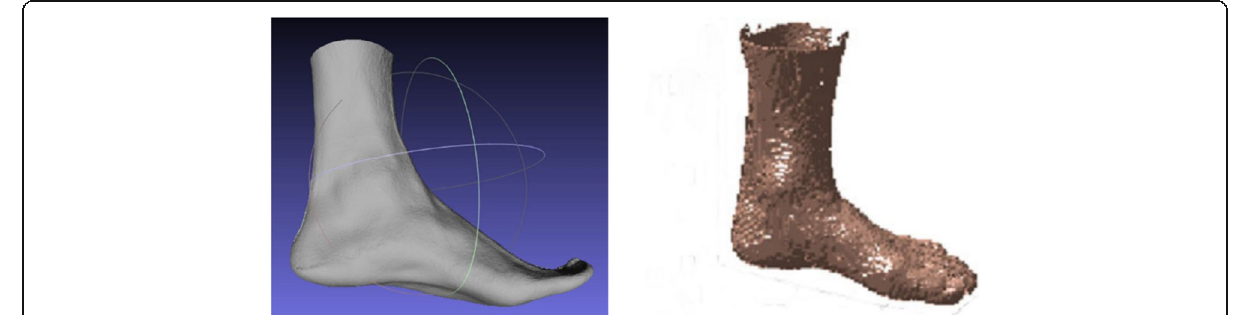
Fig. 4 Comparison of 3D reconstruction effect of foot shape